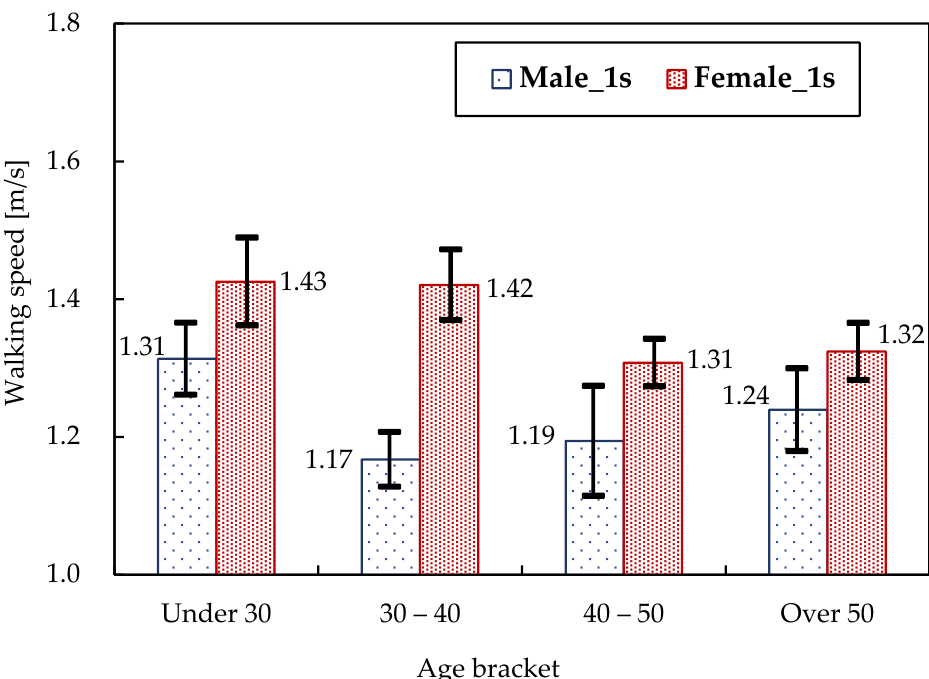
Figure 7. Walking speeds in the no motorbike section.